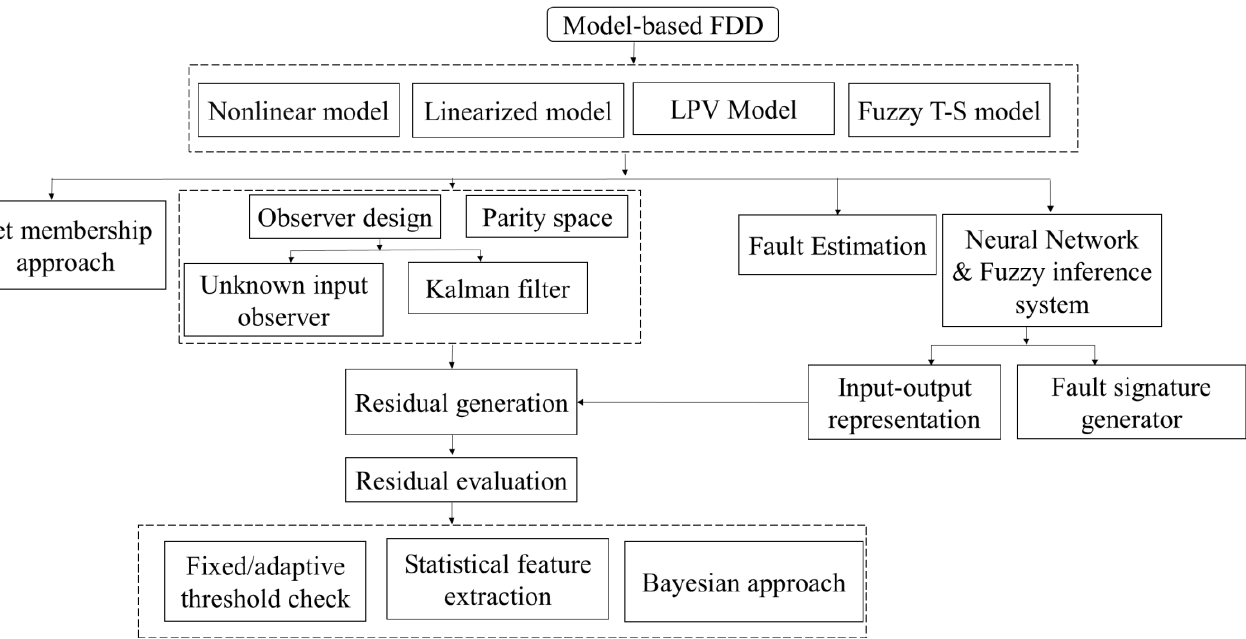
Figure 5. Illustration of Model-Based Fault Detection TPP Systems.